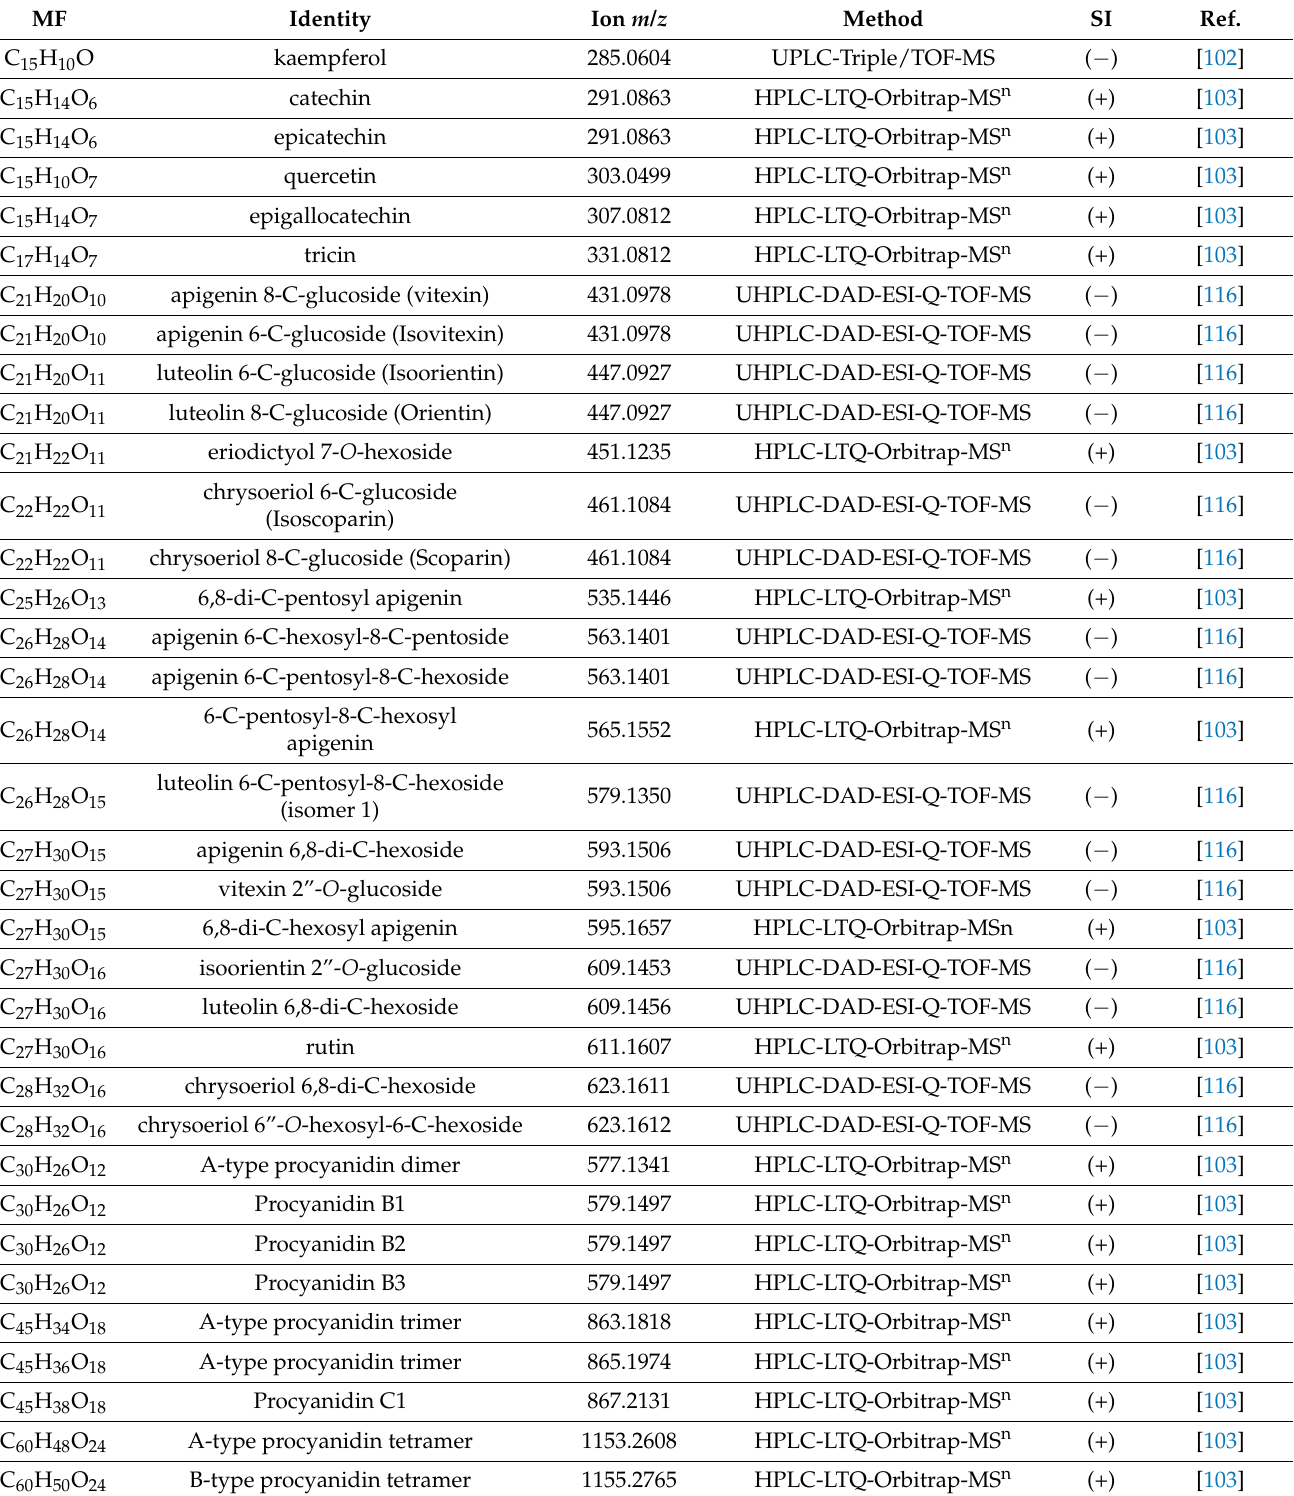
Table 2. Flavonoids and proanthocyanidins detected in rice using HPLC and MS-based methods. MF SI